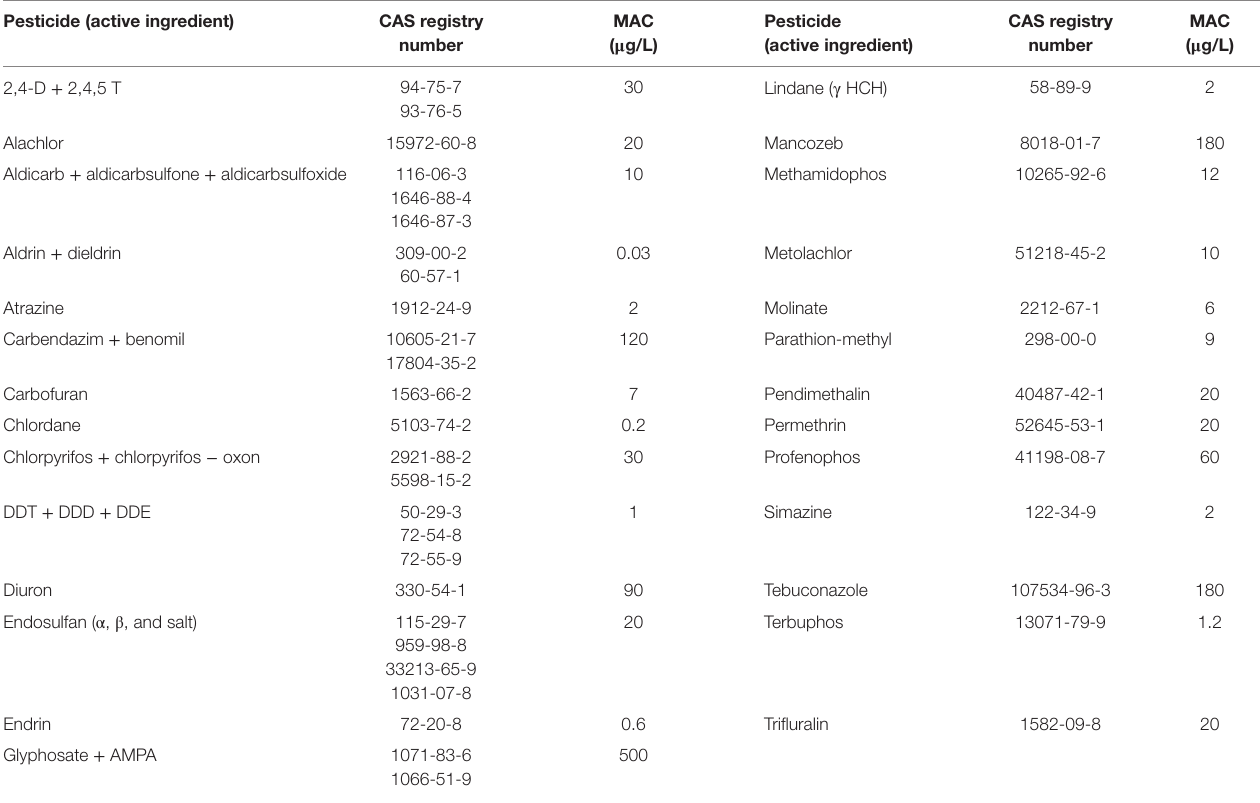
TaBle 1 | Pesticides regulated by Brazilian Ordinance Mh no. 2914/2011 and their maximum allowed concentrations (Mac) (29). Pesticide (active